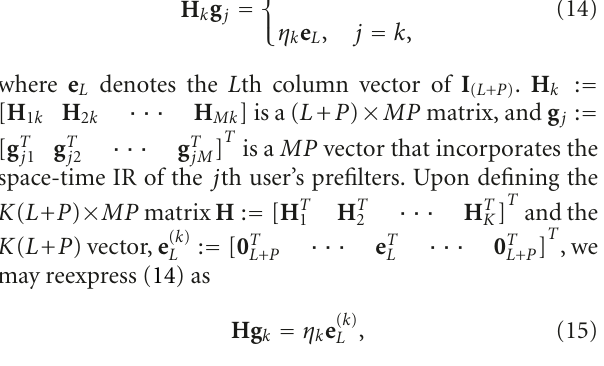
Figure 2: SINR performance with respect to the number of transmitting